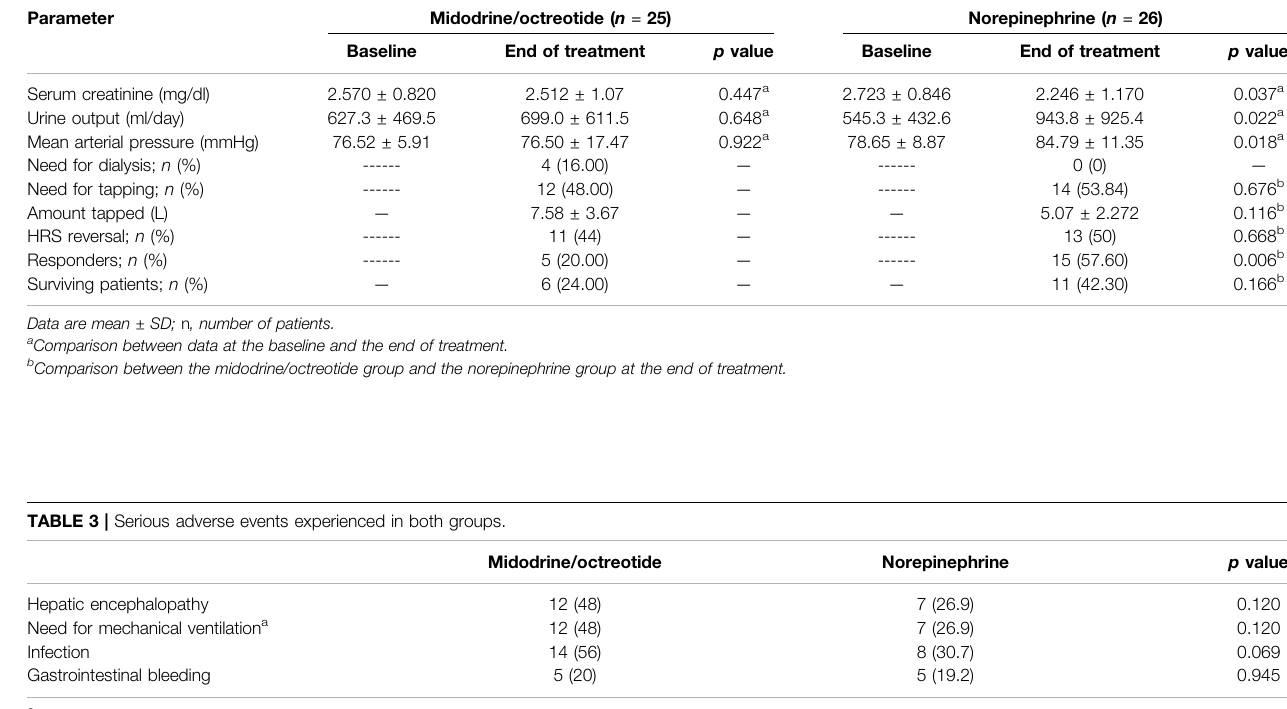
Frontiers in Pharmacology |